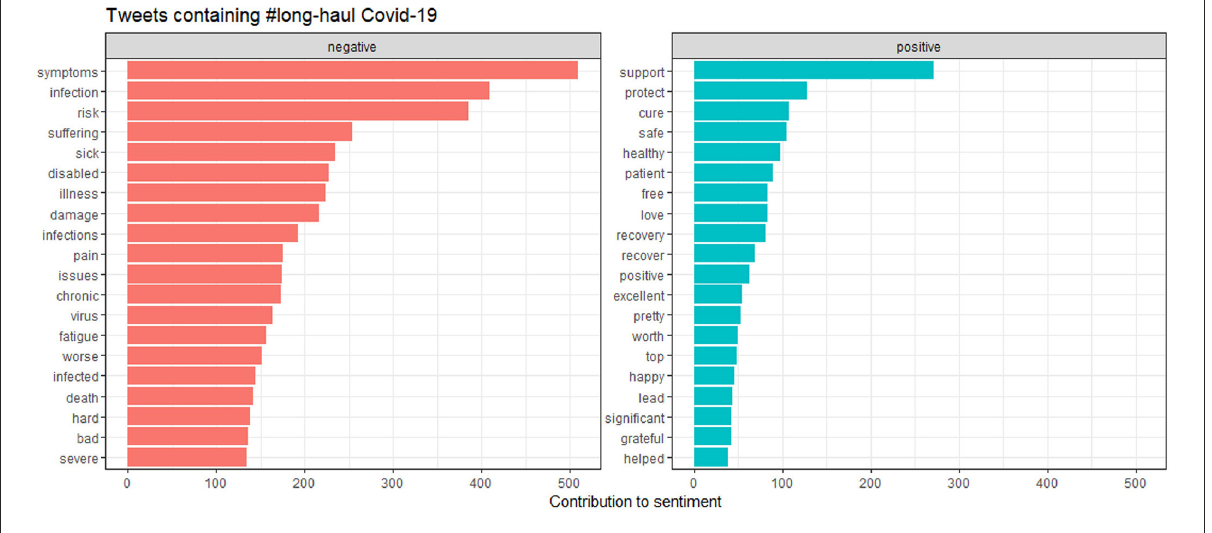
FIGURE12 The contribution of positive and negative sentiments.